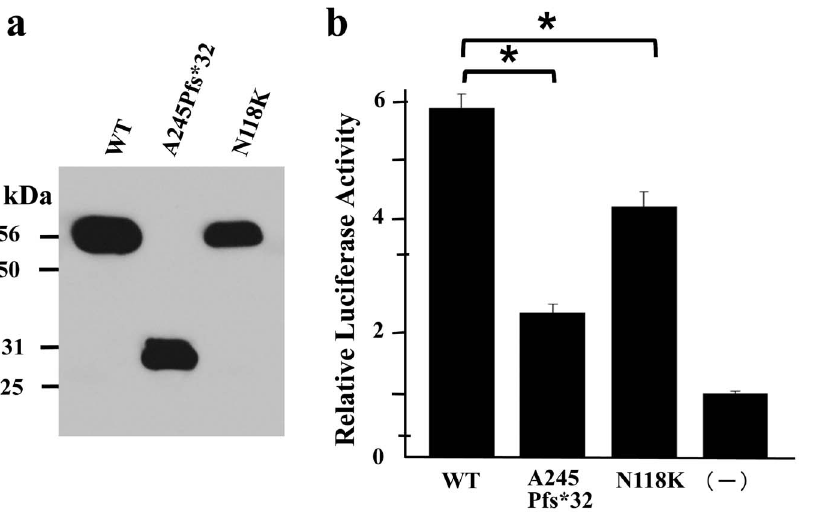
Figure 5. Loss of function of the FOXC2 mutations. a) Western blot analysis. Transfected COS-7 cells were resolved by SDS-PAGE and detected by immunoblot for the N-terminal FLAG epitope. As expected, the wild-type (WT) and N118K FOXC2 proteins were 56 kDa in size, while A245Pfs*32 FOXC2 protein was 31 kDa in size. b) Dual luciferase assay. Luciferase activities of WT, A245Pfs*32 and N118K FOXC2 vectors compared with that of the empty vector (-). The significance was analysed with t-test. The activities of A245Pfs*32 and N118K FOXC2 had significantly decreased compared to that of WT FOXC2. Thick bar: mean value, error bar: SD, asterisk: p value , 0.01. doi:10.1371/journal.pone.0080548.g005 PLOS ONE |